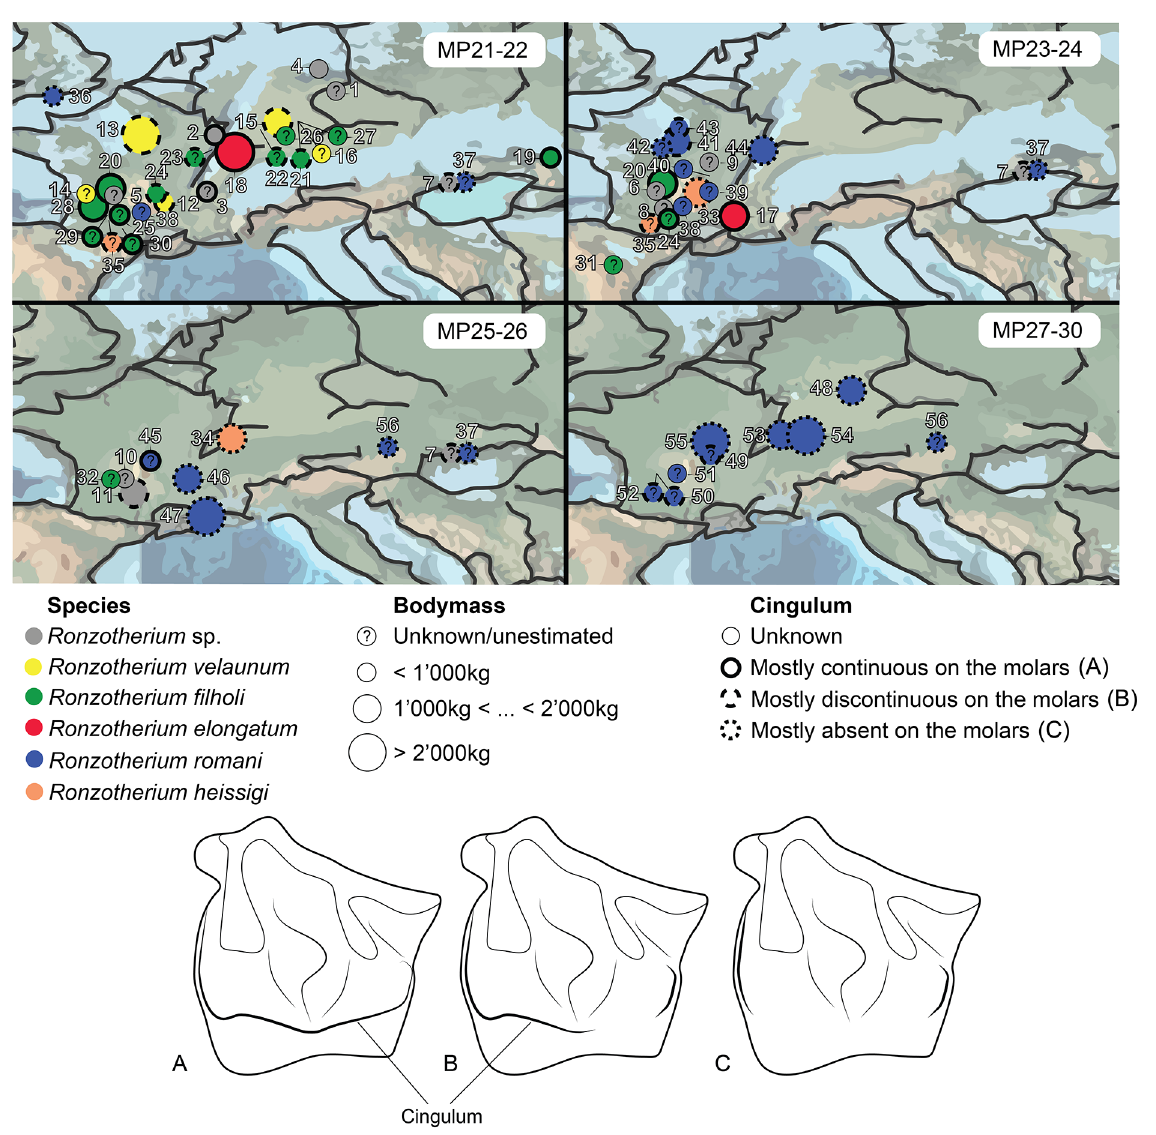
Fig. 27. Occurrences of Ronzotherium Aymard, 1854 in Europe, from MP21 (earliest Oligocene) to MP30 (latest Oligocene) with palaeogeographical reconstructions, modified from PALEOMAP (Scotese 2016). The diameter of the circles is proportional to the body mass of the specimens in each locality, and the thickness and shape of the outline refer to the shape of their cingulum. Numbers of circles refer to the number of the locality in Supp. file